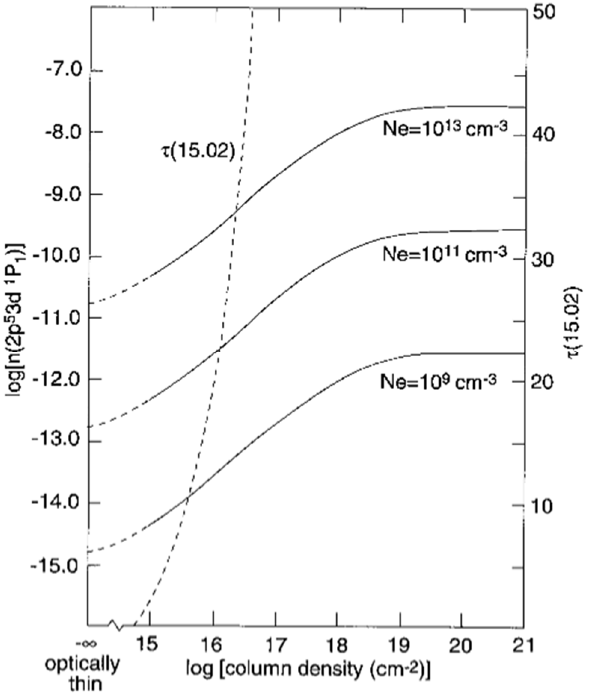
Figure 3. Variation of the population of upper level 3 p 5 3 d 1 P 1 of the 15.02 Å resonance line, with increasing column density of Fe XVII.